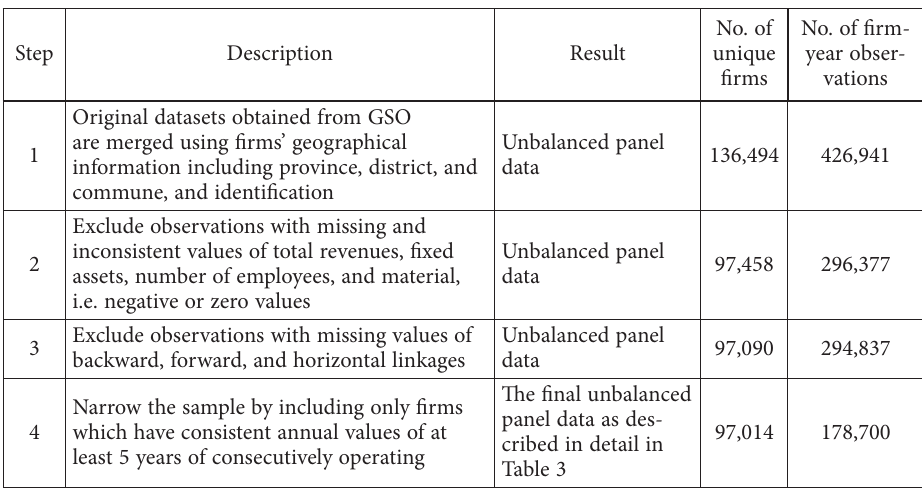
Table 2. Data processing for the sample of manufacturing firms over the period 2010–2016 (source: authors’ calculation from VAES 2010-16)